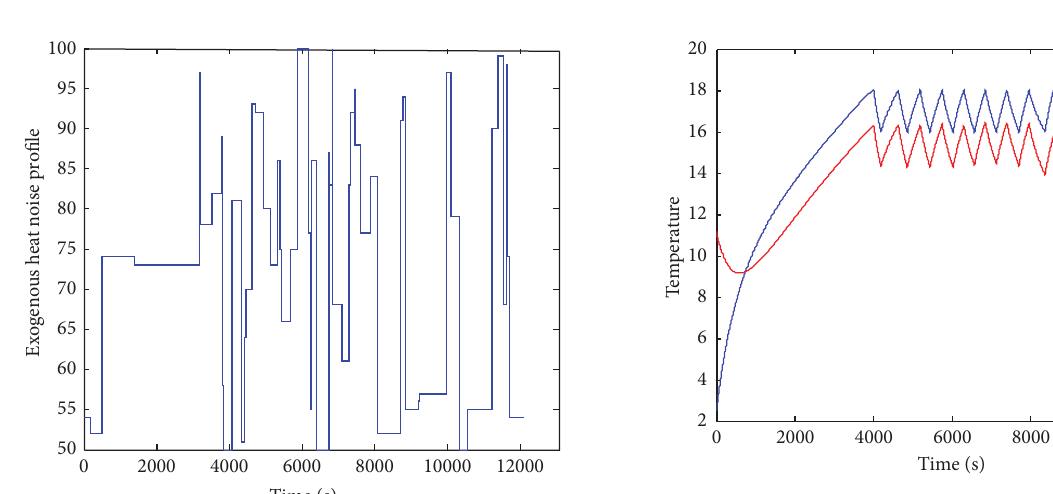
Figure 14: Real and predicted temperature of zone I, with an exogenous heat noise depicted in Figure 13 and an extra heat source powered on at 𝑛 = 8000